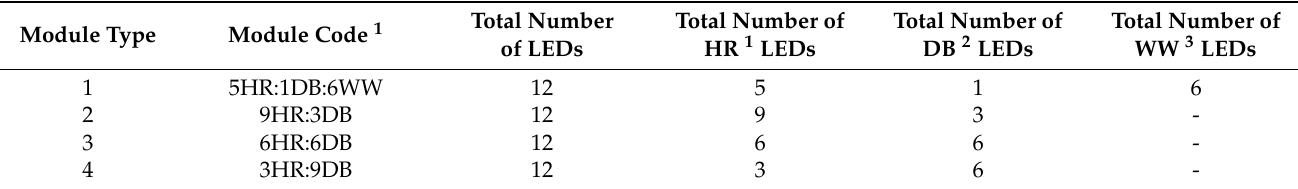
Table 1. Composition of the LEDs modules used in the experiments to realize the considered light combinations. Module